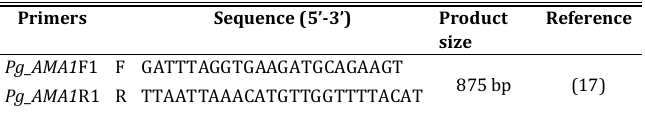
Table 1 . Primers used for amlification hypervariable domain I region of ama-1 gene